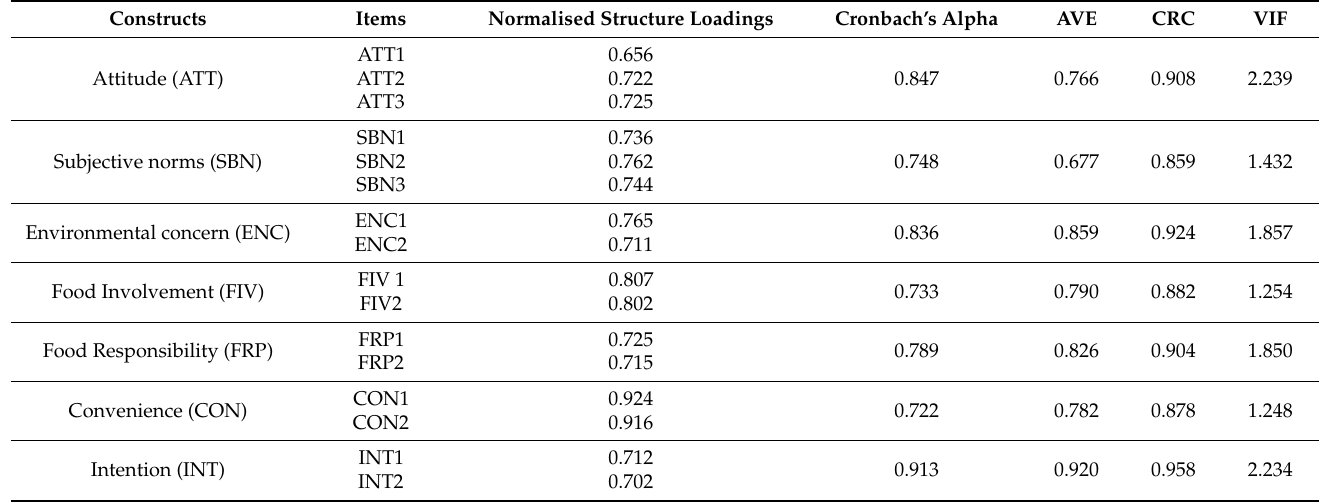
Table 5. Confirmatory factor analysis, validity, reliability, and multicollinearity